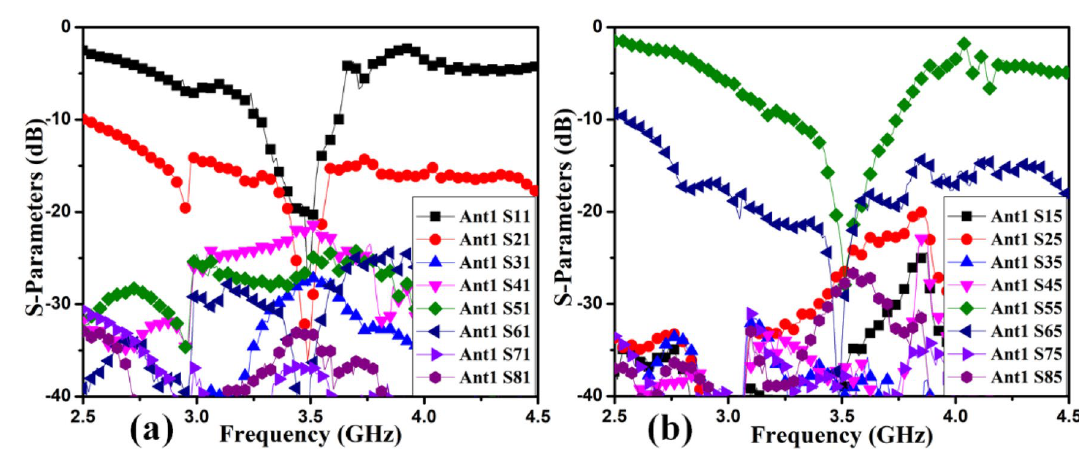
Figure 21. Proposed 8 Members MIMO antenna Measured S-Parameters ( a ) Ant 1, ( b ) Ant